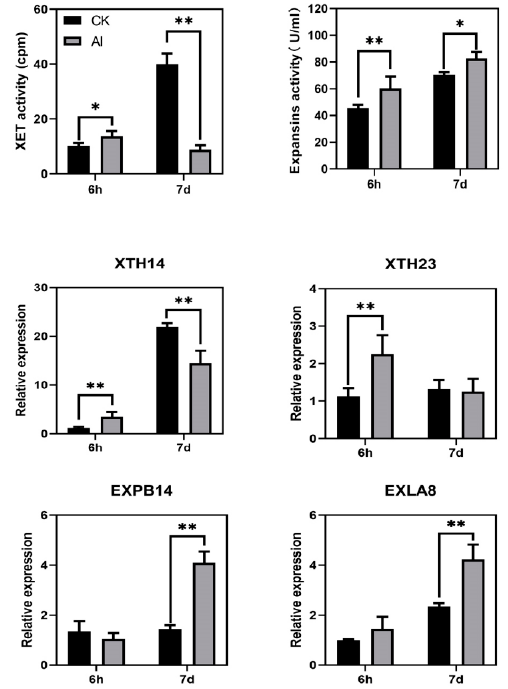
Figure 7. Change in XET and expansin activity and the expression of related genes in the root base after treatment for 6 h and 7 d with Al compared with the CK group (*, ** indicate significance at 0.05 and 0.01 probability levels,